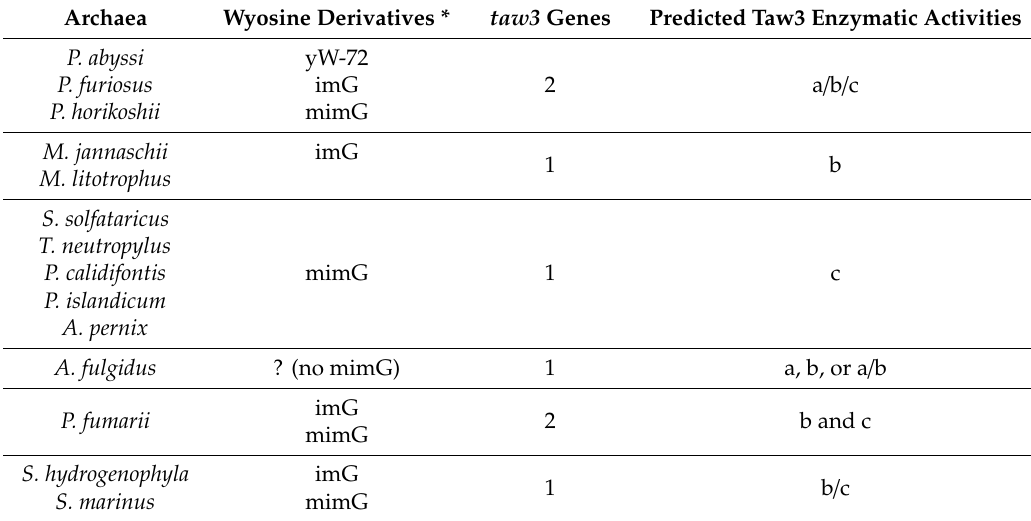
Table 1. Correlation between the presence of wyosine derivatives in certain archaeal species, number of taw3 genes, and predicted Taw3 enzymatic activities. Archaea Wyosine Derivatives * taw3